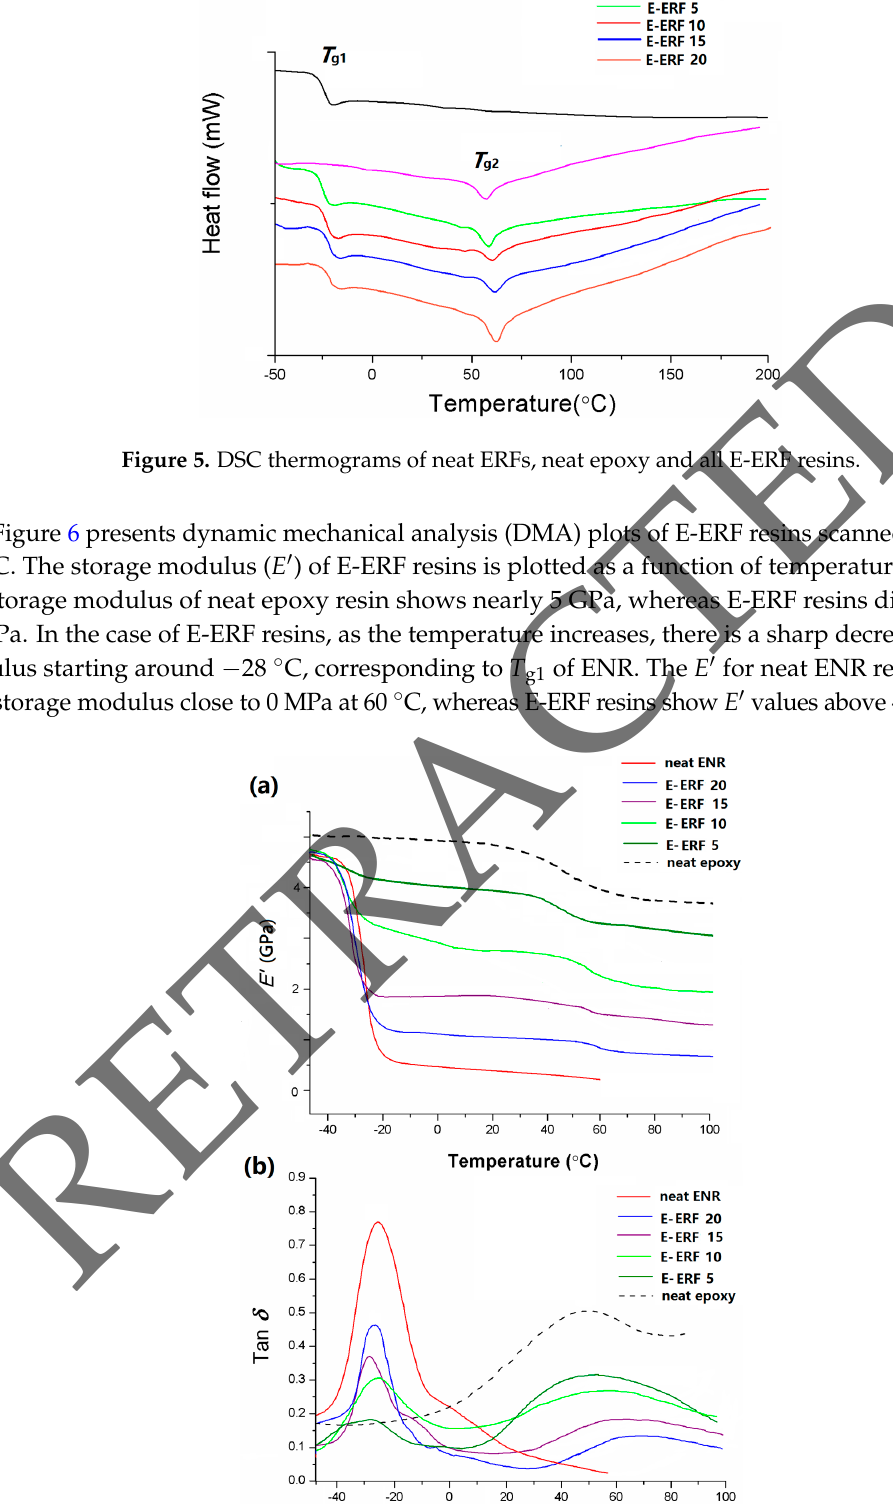
Figure 6. DMA plots of neat epoxy resin, neat ENR sheet, and E-ERF resins at different loading of